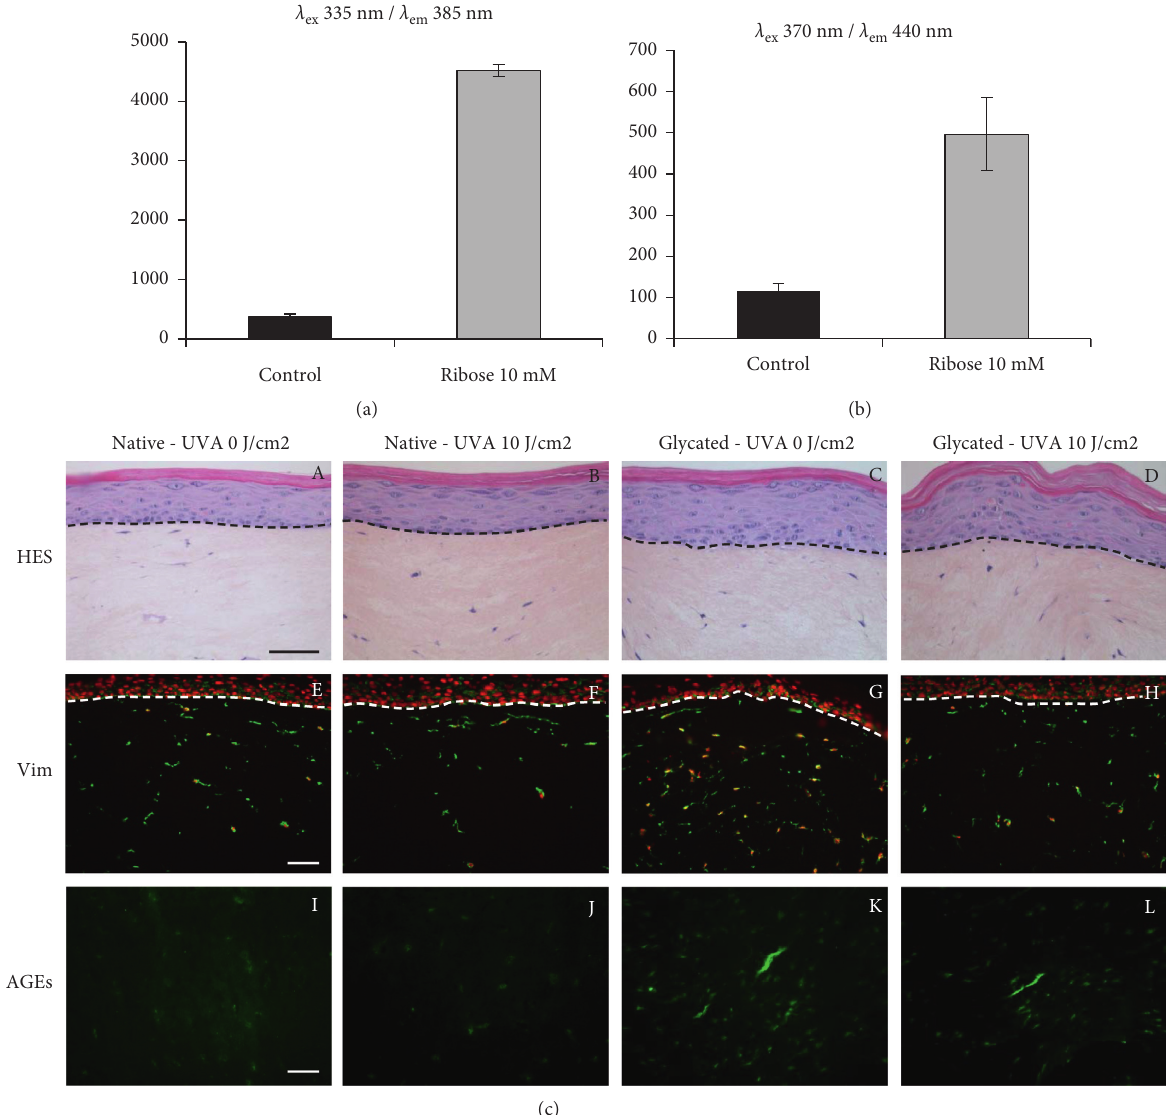
Figure 1: Demonstration of the presence of AGEs and morphology of the reconstructed skin. Fluorescence measurement of collagen solution before reconstruction of the skin at λ ex 335nm/ λ em 385nm (a) and λ ex 370 nm/ λ em 440nm (b). Control: native collagen solution; ribose 10mM: collagen solution modified by glycation using ribose 10mM (AU ± SD � arbitrary units ± standard deviation). Reconstructed skin (c): HES histological staining (A to D), vimentin (E to H), and AGEs (I to L) labelling of skin reconstructed in vitro using untreated collagen (A, B, E, F, I, J) or preglycated collagen (C, D, G, H, K, L) after (B, F, J, D, H, L) or without (A, E, I, C, G, K) UVA irradiation (10J/cm 2 ) (bar � 100 µ